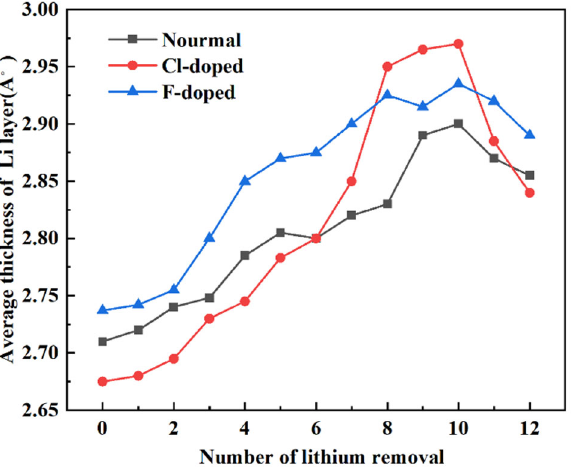
Figure 8. Variation of average thickness of Li layer during lithium remova l.